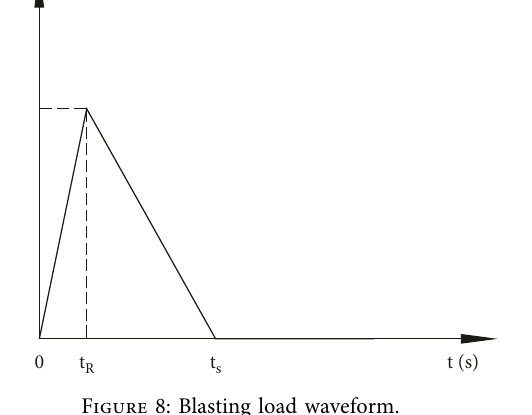
Figure 8: Blasting load